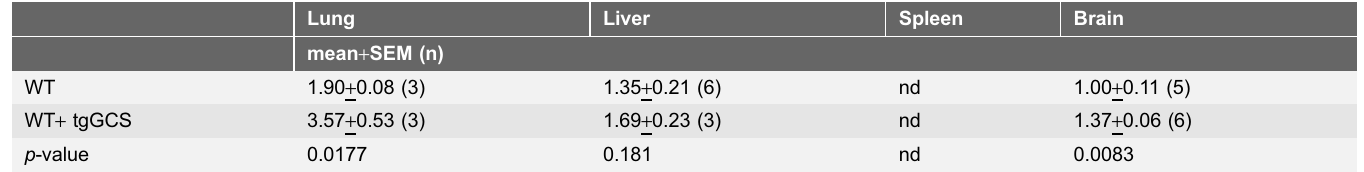
Table 1. GCS activity.